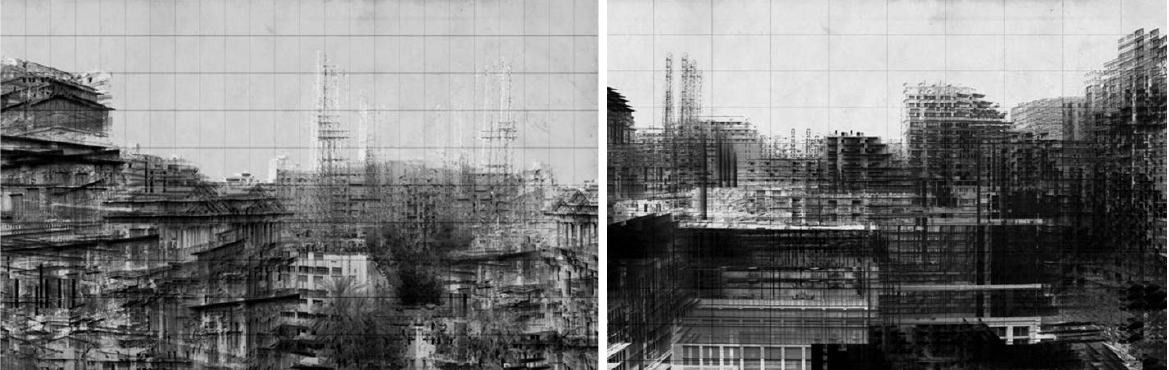
Figure 8. Amr Kafrawy: Printing and drawing on recycled paper, 220 x 100 cm, 2012